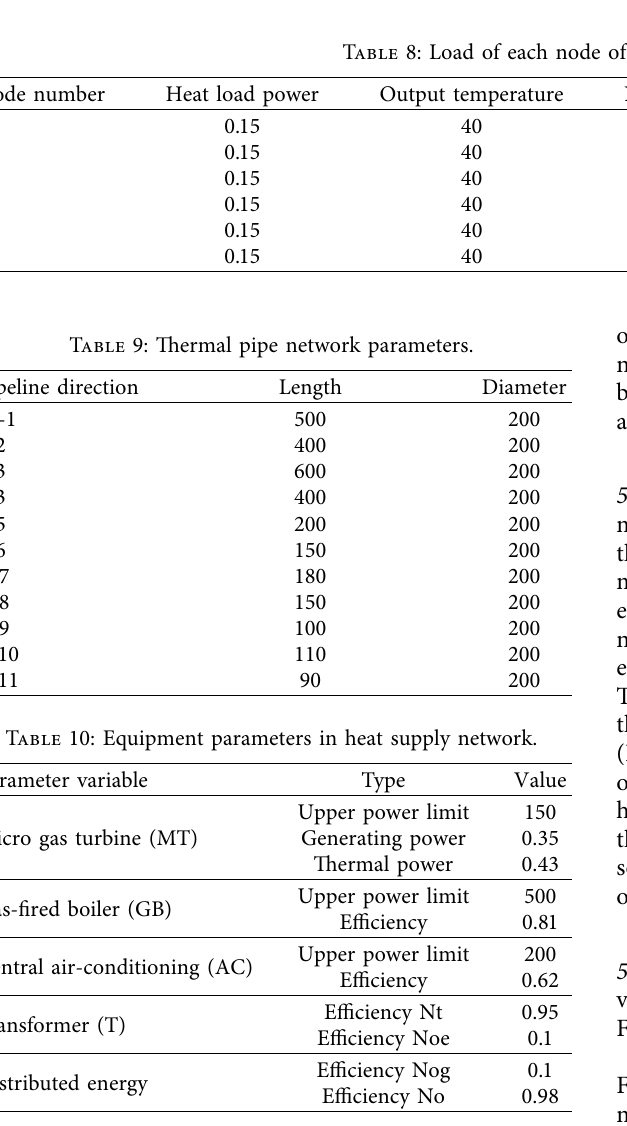
Table 8: Load of each node of the thermal subsystem.